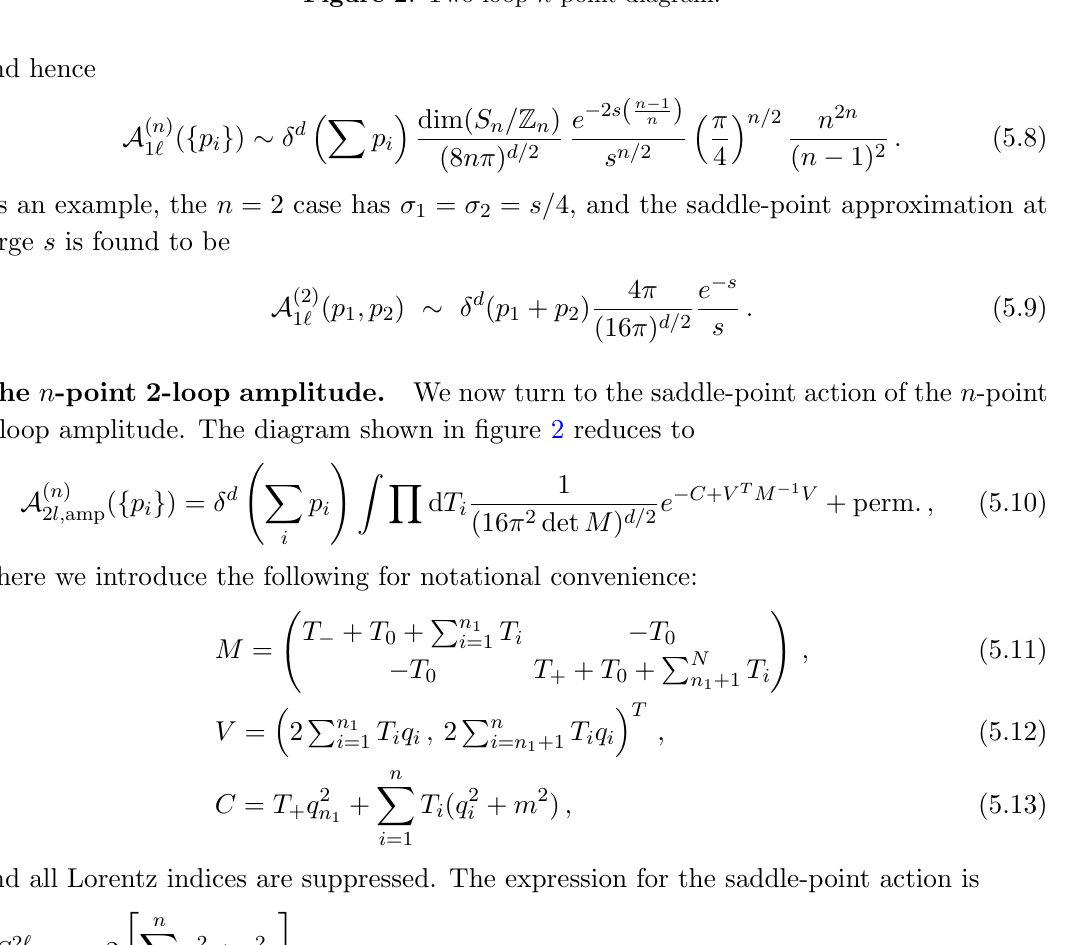
Figure 2 . Two-loop n -point